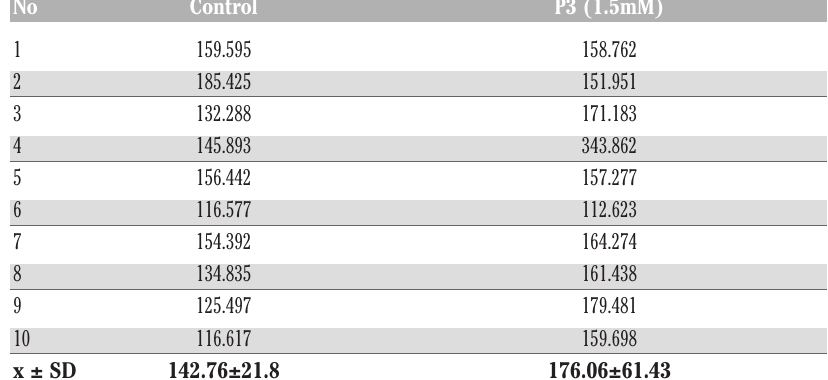
Table 3. Intensity of Ca 2+ au control group vs P3 (the best